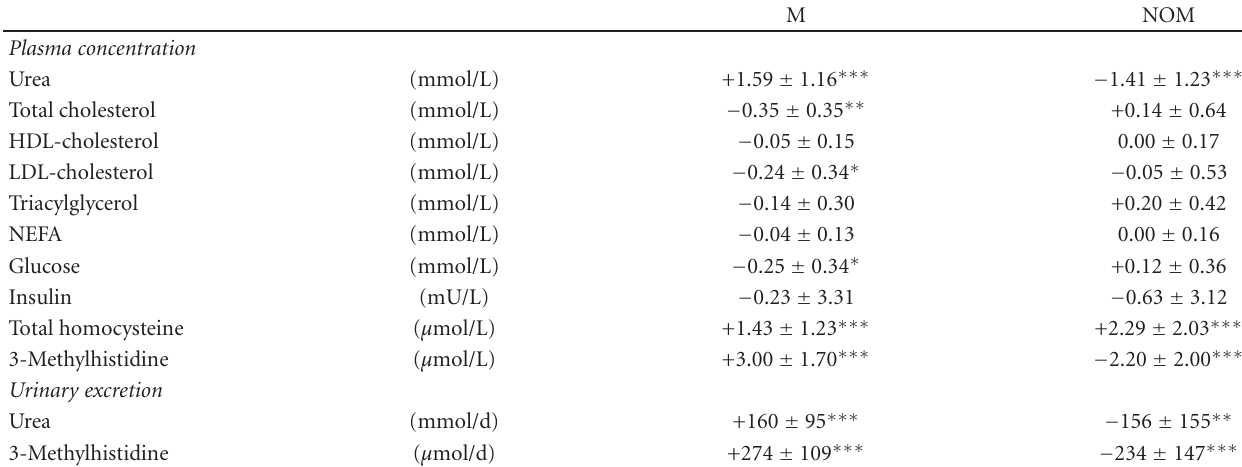
Table 4: Changes of plasma metabolite concentrations and urinary excretion of urea and of 3-methylhistidine of women during 4 weeks periods of either additional meat consumption (M, 200g pork fillet/d) or exclusion of meat products (NOM). 1